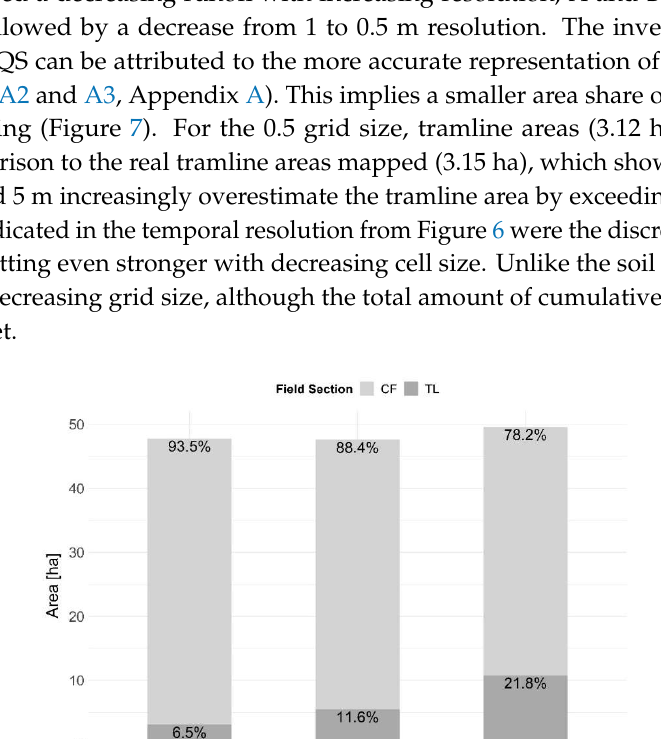
Table 3. Comparison of tramline (TL) and cultivated field (CF) section for the parameters Sediment Budget and Runoff for different fields for 1 m resolution.